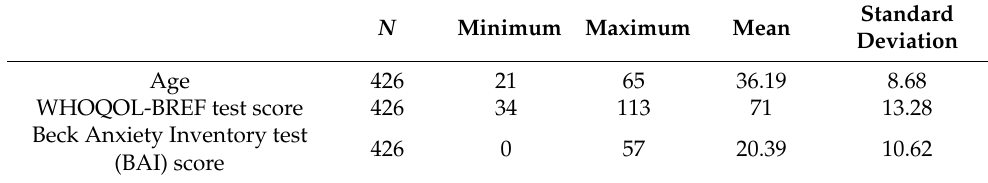
Table 2. Descriptive analysis of quantitative